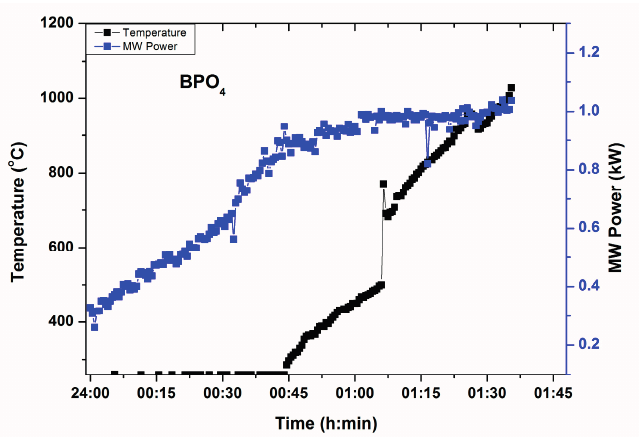
Figure 3. T-P-t profile of BPO 4 in absence of microwave